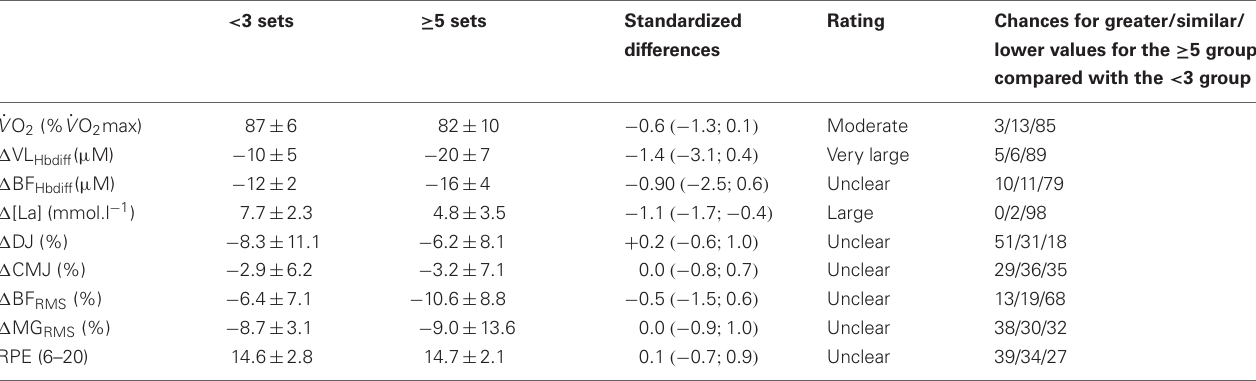
Table 2 | Physiological responses to the first two sets of HIT for the team sport players with respect to the number of HIT sets completed before